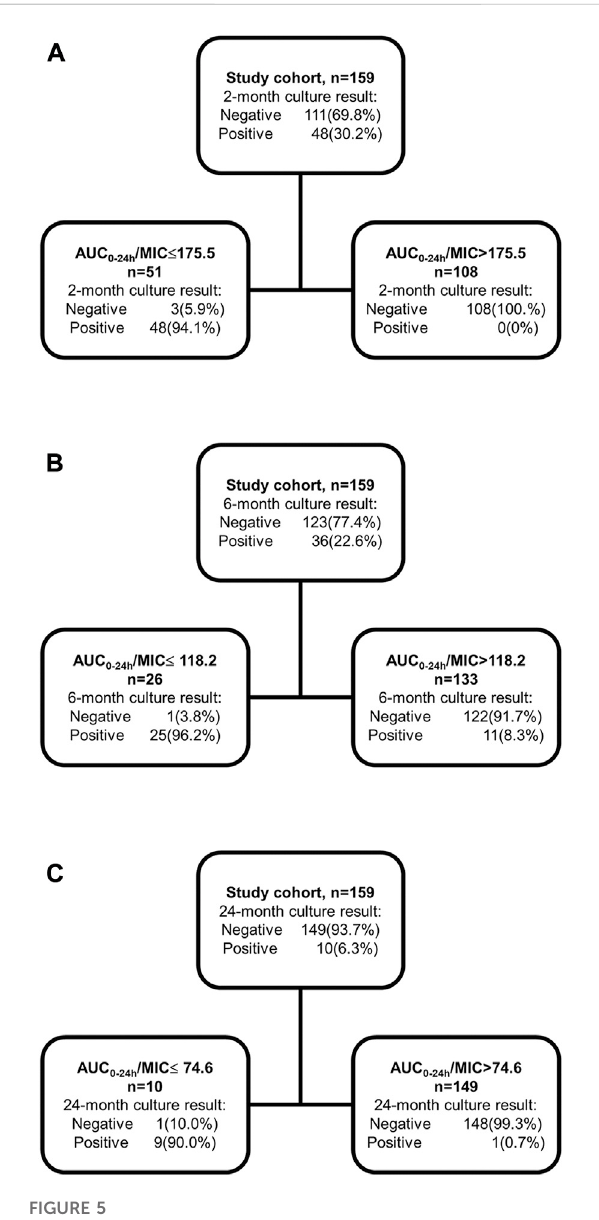
FIGURE 5 Classi fi cation and Regression Tree analysis for the thresholds to differentiate the 2-month, 6-month sputum conversion and successful treatment outcome in the validation cohort. Classi fi cation and Regression Tree analysis was applied to identify the thresholds predictiveof2-month (A) ,6-month (B) sputum conversion and successful treatment outcome (C) . AUC 0-24h : area under drug concentration-time curve over the last 24-h dosing interval; MIC: minimum inhibitory